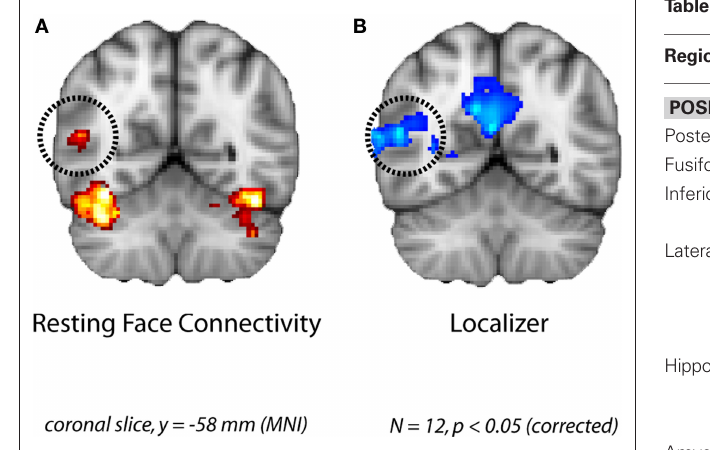
FIguRe 2 | Face-specific connectivity from experiment 1. (A) Group analysis of resting correlations with each subject’s face-specific FG after removing variance from the control region. (B) The pSTS region that was correlated with the FG at rest overlapped with the face-selective pSTS region obtained in a group analysis of the localizer runs.